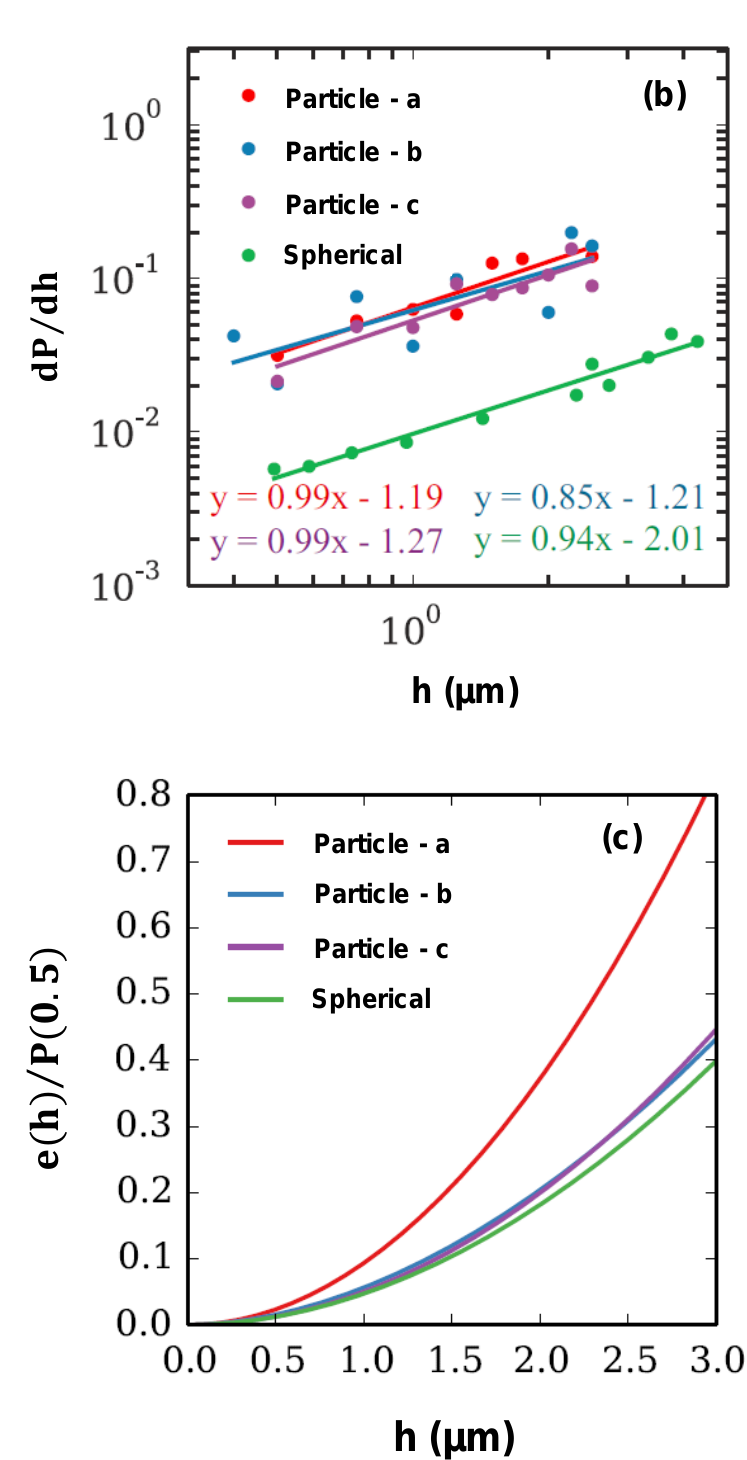
Figure 4. ( a,b ) Convergence of the derivative of Weibull fracture probability in particles with different geometries, and ( c ) corresponding estimated probability error.